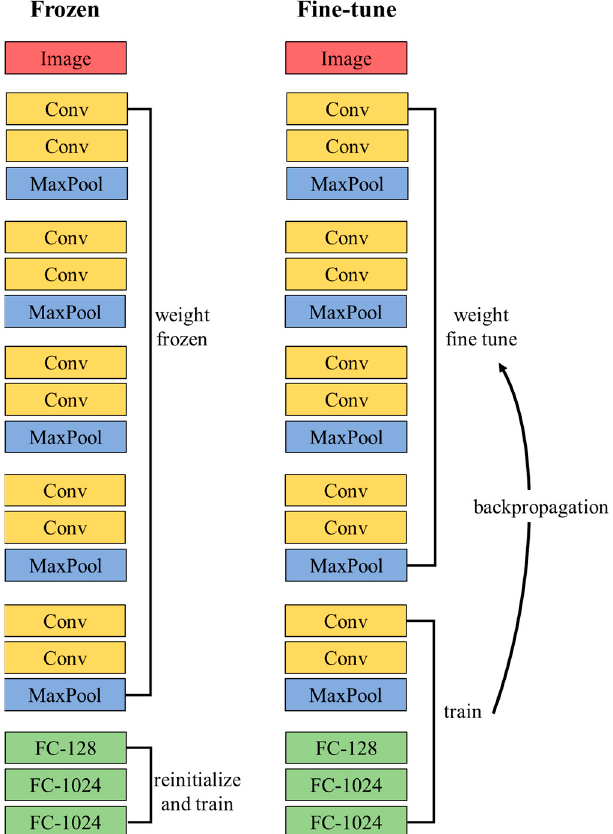
Figure 1. Schematic diagram of the training process of freezing and fine-tuning of the transfer learn- ing method for image analysis. learning method for image